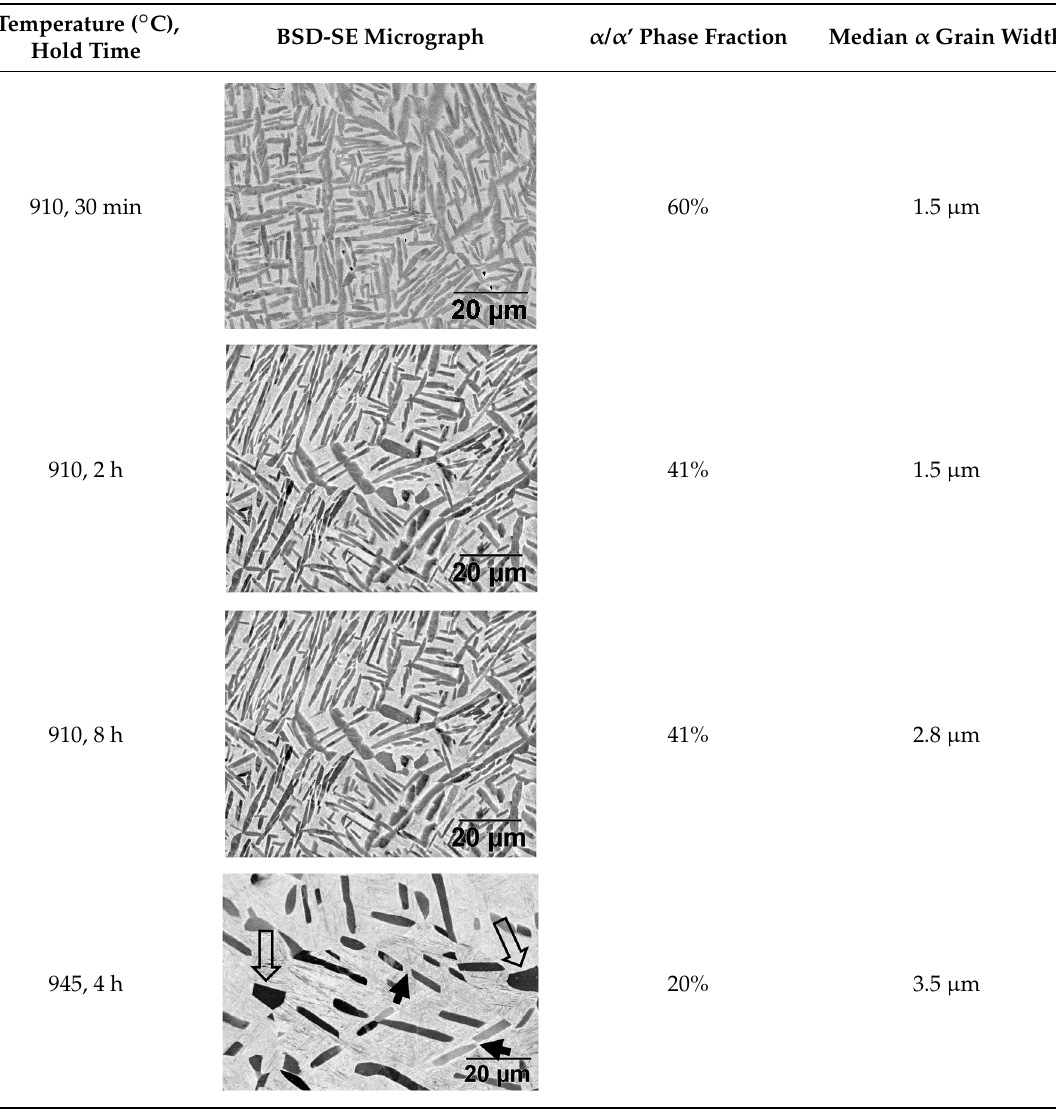
Table 6. Microstructure—annealing at 910 °C and 945 °C. Grain fragmentation and globularisation is indicated by solid and hollow arrows respectively.